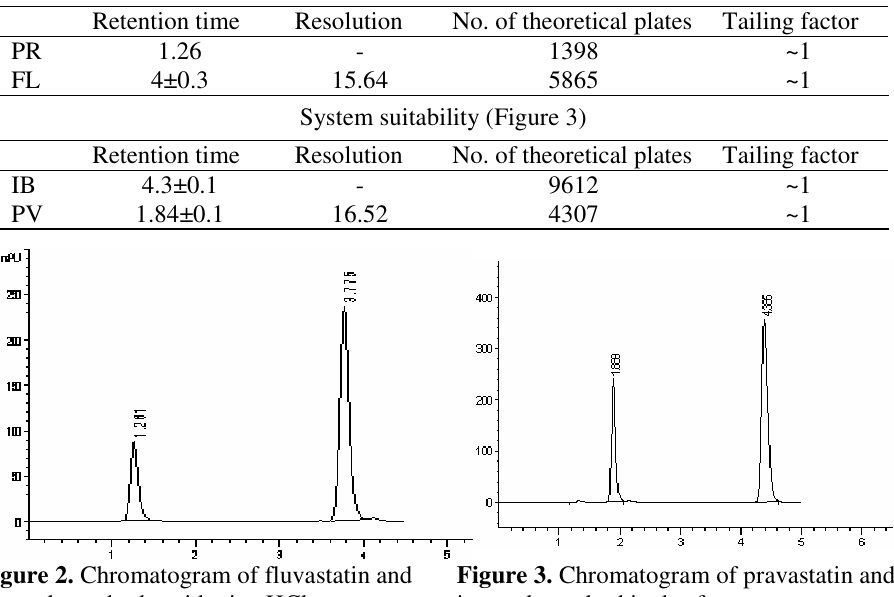
Figure 3. Chromatogram of pravastatin